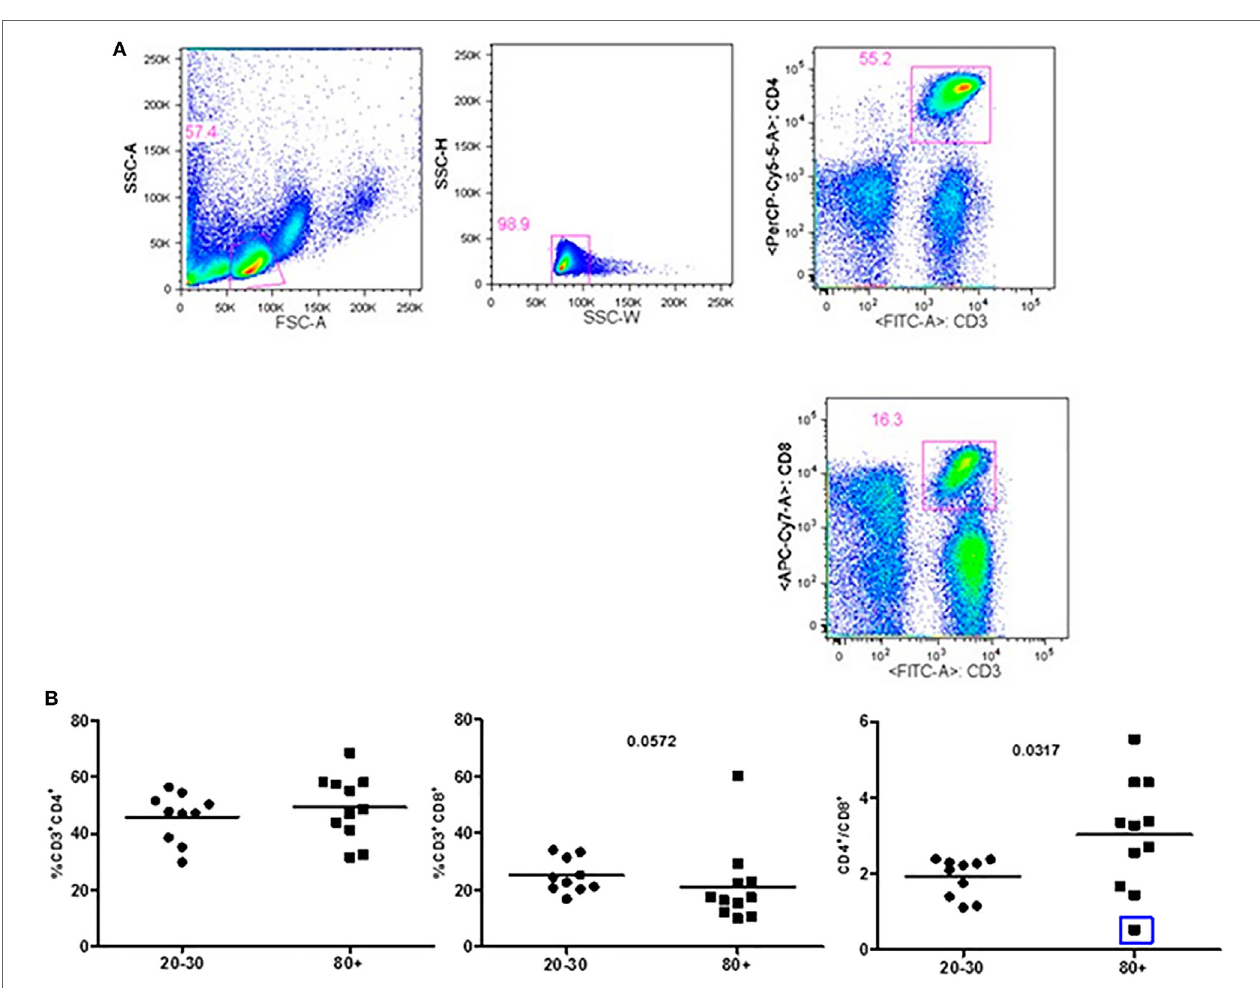
FigUre 2 | Representative flow cytometry plots showing gate strategy for the frequency of CD4 + and CD8 + T cells. Gate in live lymphocytes (FSC-A × SSC-A), doublets exclusion (SSC-H × SSC-W), gate in CD3 + CD4 + T cells, gate in CD3 + CD8 + T cells (a) . Frequency of T lymphocytes CD3 + CD4 + , CD3 + CD8 + , and CD4/CD8 ratio in 20–30 and 80 + years old individuals. The CD4/CD8 ratio lower than 1 (0.542; blue square) (b)